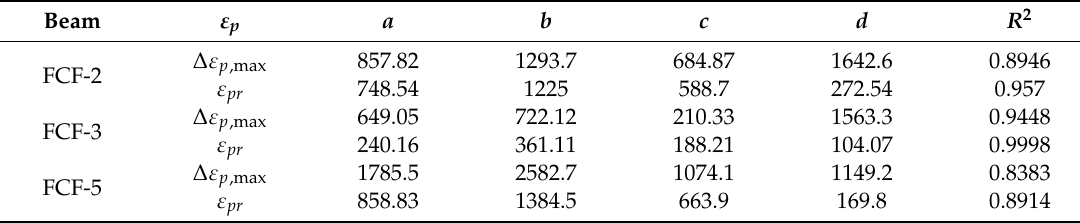
Table 5. Parameters of strain calculation equation.